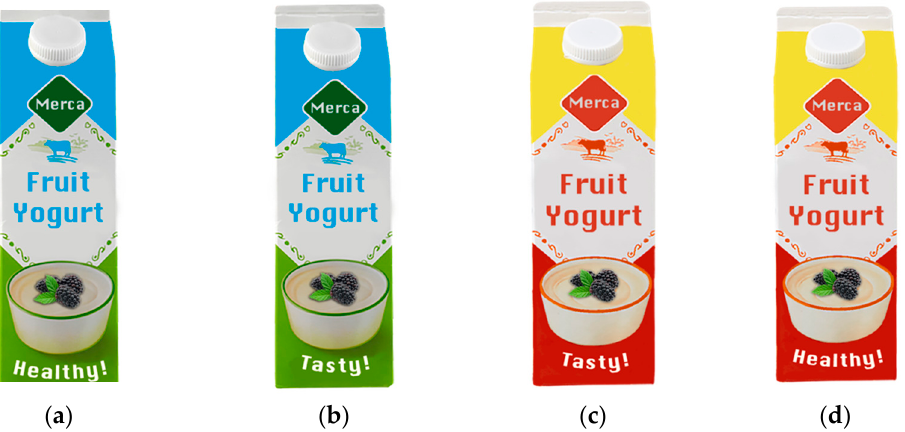
Figure 1. Visualization of the four conditions. ( a ) Healthy colors, health claim. ( b ) Healthy colors, palatability claim. ( c ) Unhealthy colors, palatability claim. ( d ) Unhealthy colors, health claim.